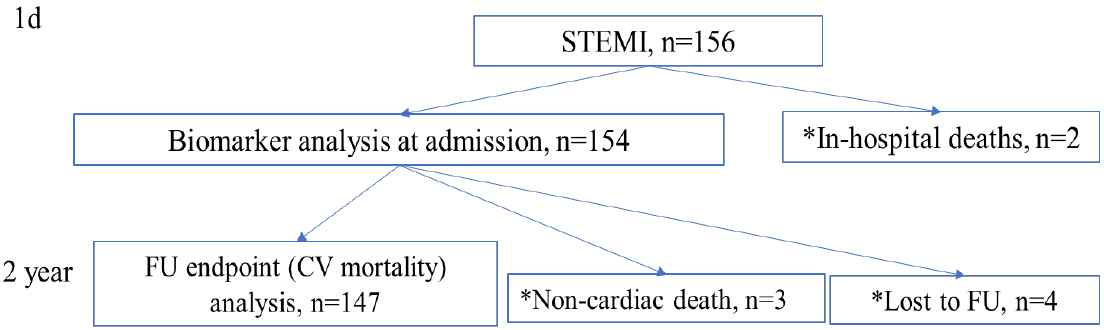
Figure 1. Patient enrollment and the design of the study. * — patients were excluded from the study. FU — follow-up, STEMI — ST-elevation myocardial infarction.